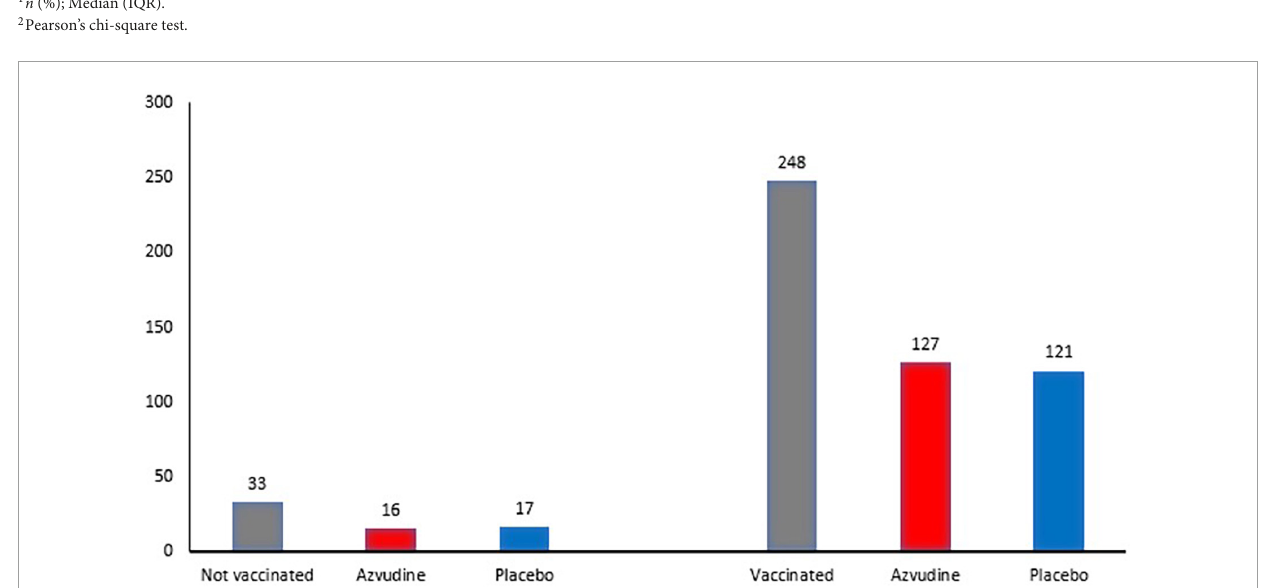
FIGURE4 Quantification of vaccinated and unvaccinated participants included in the study and its distribution between the FNC and placebo groups.